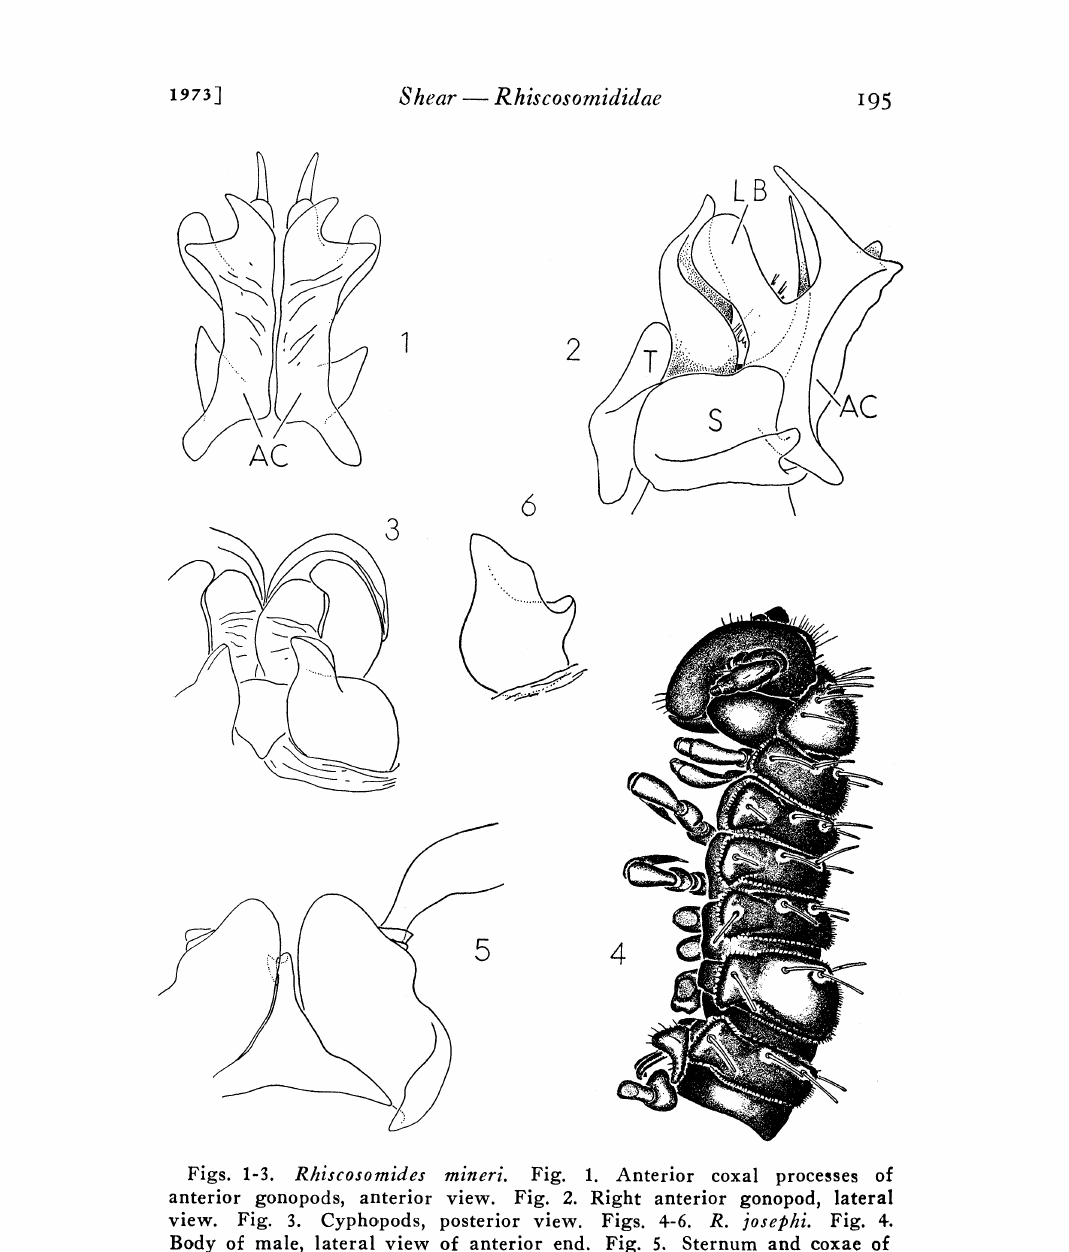
Figs. 1-3. Rhiscosomides mineri. Fig. 1. Anterior eoxal processes of anterior gonopods, anterior view. Fig. 2. Right anterior gonopod, lateral view. Fig. 3. Cypho.pods, posterior view. Figs. 4-6. R. josephi. Fig. 4. Body of male, lateral view of anterior end. Fig. 5. Sternum and eoxae of legs 2 of female, pos.terior view. Fig. 6. Left postgenital structure of female, posterior